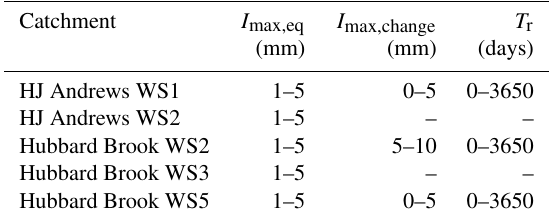
Table 2. Applied parameter ranges for root-zone storage